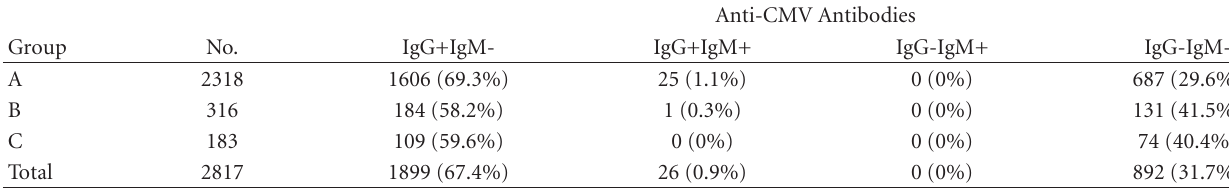
Table 1: Anti-CMV IgG and IgM antibody seroprevalence (ELISA) in pregnant women by trimester of first screening (groups A–C). Anti-CMV